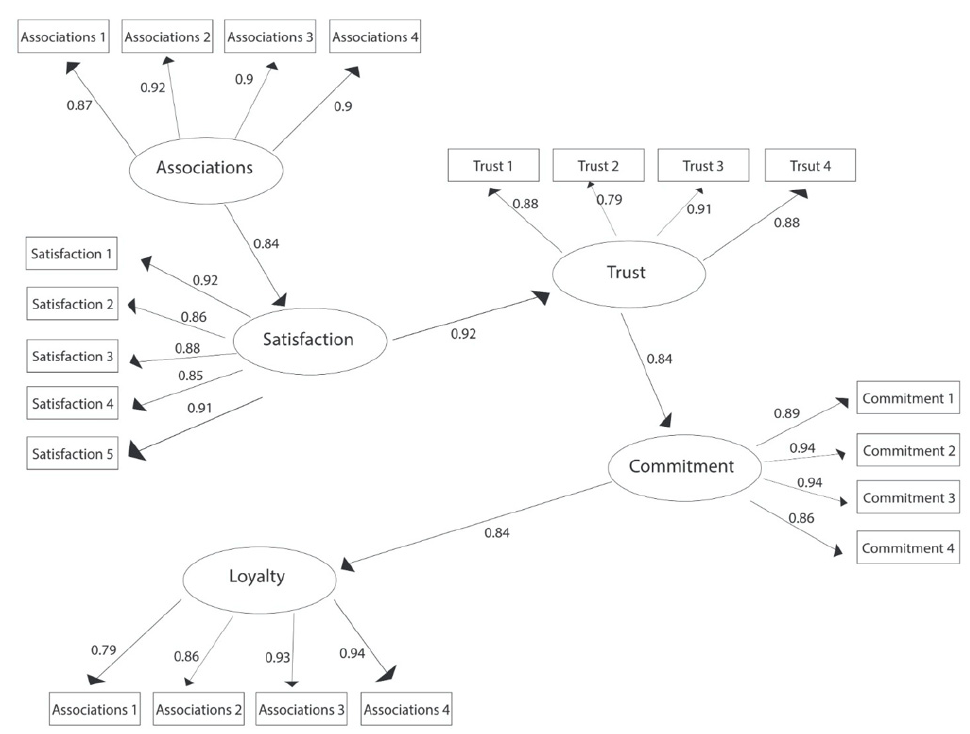
Figure 3. The structural model of the relationships between the components of brand equity (brand associations, satisfaction, trust, brand commitment, brand loyalty) from the perspective of AES stu- dents.